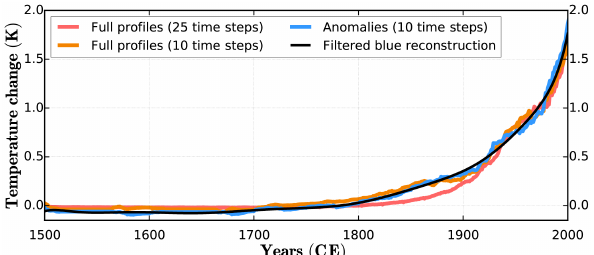
Figure A1. Mean North American GST histories for different parametrizations. Full inversions have been done for two different time distributions: 10 time steps using Eq. (15) (orange) and 25 time steps of 20 years each (red). Furthermore, a mean GST history (blue) obtained from the reconstruction of the anomalies using the linear regression method has been added. Its filtered version (black) is presented in Fig.